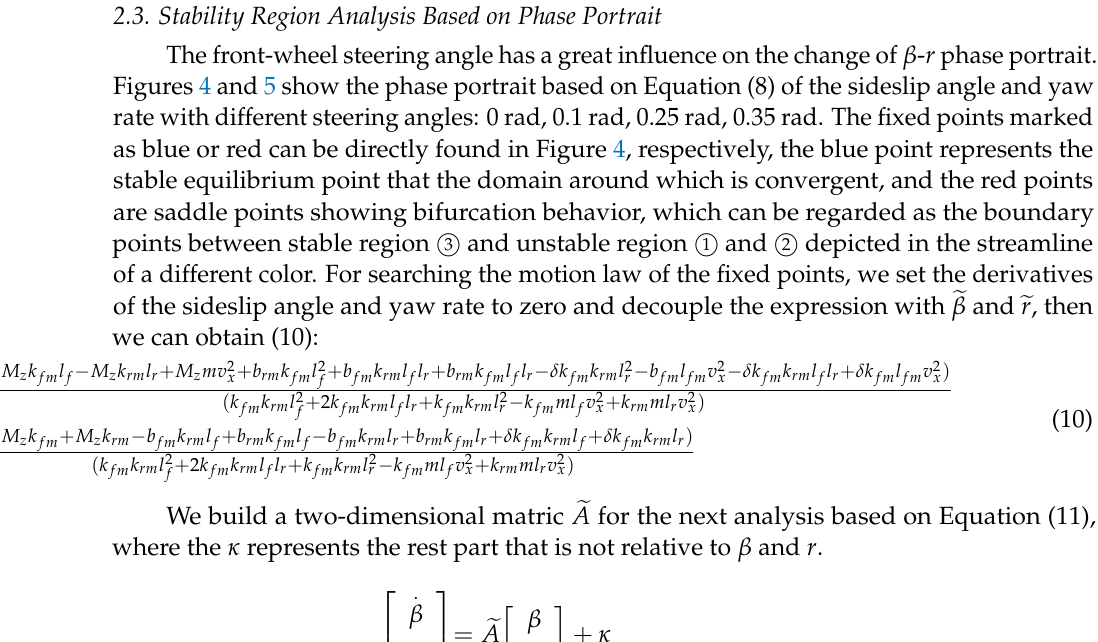
Figure 3. Full-wheel drive vehicle model.